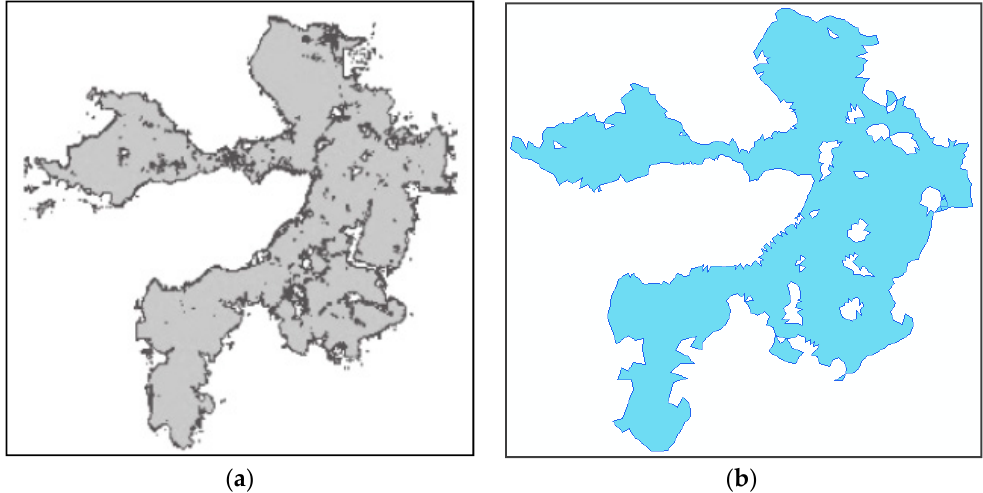
Figure 7. Distribution of water patches as determined by ( a ) remote sensing image and ( b ) MIKE21 software.